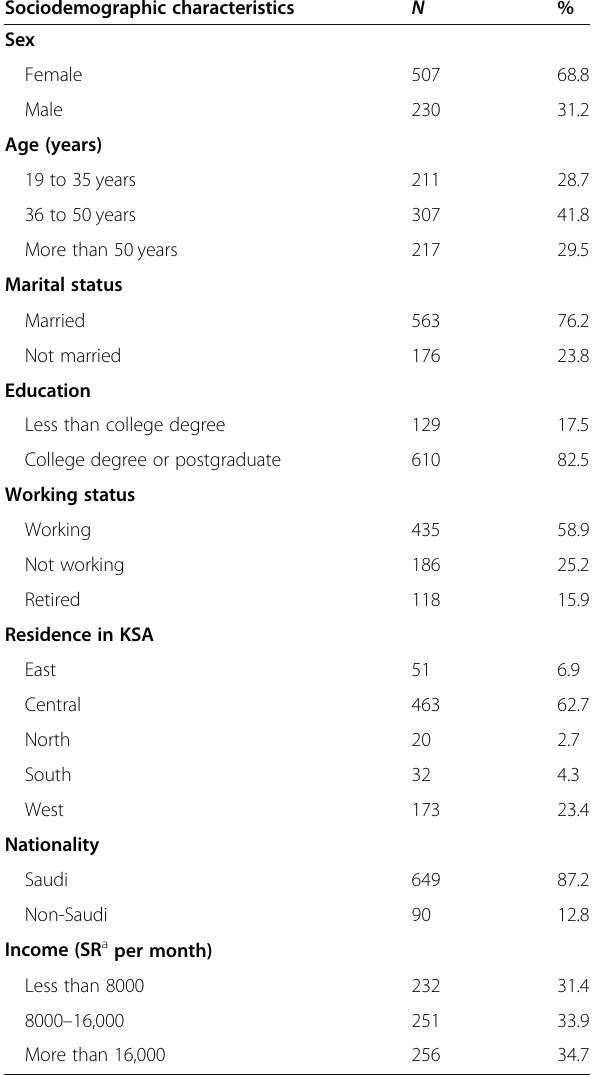
Table 1 Sociodemographic characteristics of the study sample ( n = 739) Sociodemographic